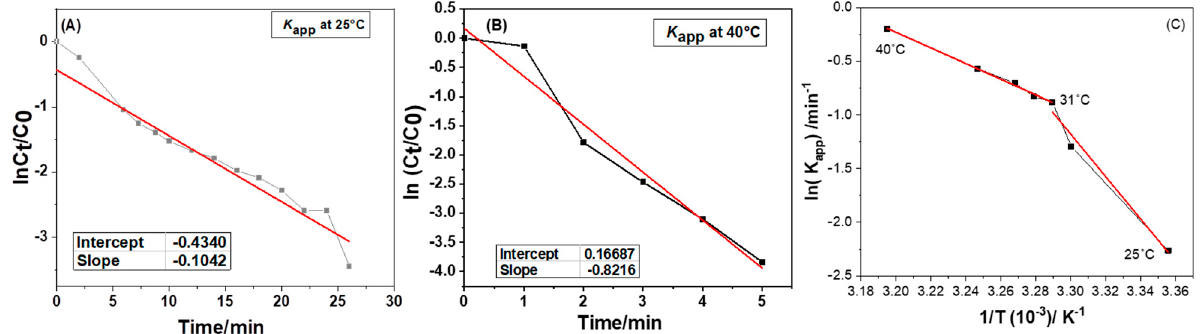
Figure 5. Pseudo-first order kinetic plots for reduction of methyl orange by using Ag-embedded NIPAM based cryogels (CR-Ag) at different temperatures: (A):25 ˚ C (B) 40 ˚ C.(C) Arrhenius plot for temperature dependence of degradation rate